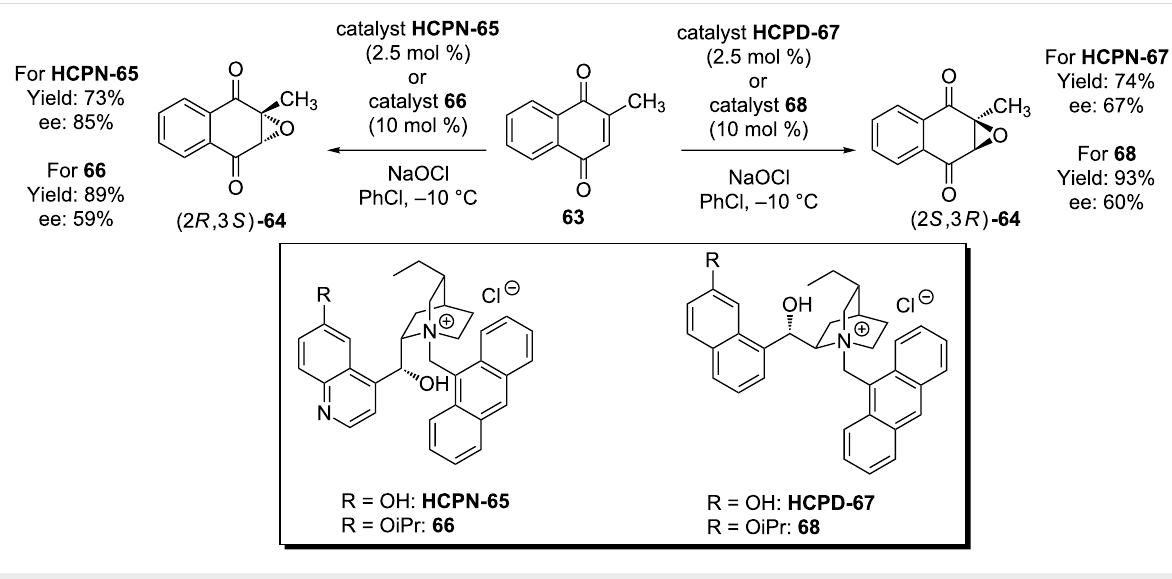
Scheme 16: The hydrocupreine and hydrocupreidine-based catalysts HCPN-65 and HCPD-67 demonstrate the potential for phase transfer catalyst derivatives of the 6’-OH cinchona alkaloids to be used in asymmetric synthesis.